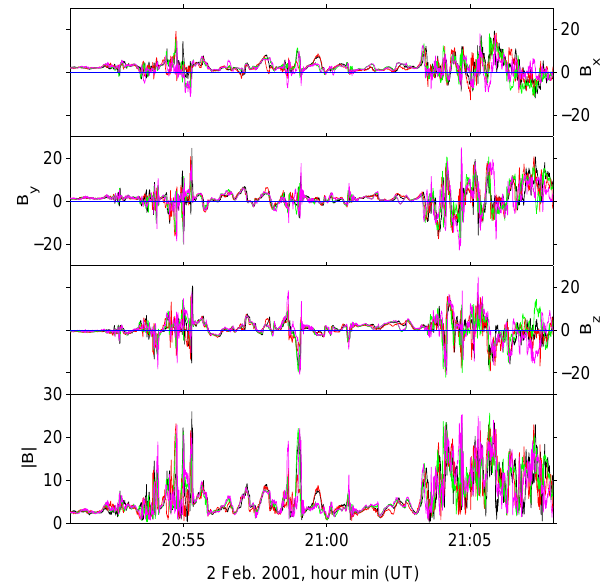
Fig. 4. Magnetic field data from the four spacecraft at 5 vectors/s from a region of the shock transition. The spacecraft are indicated by black (Cluster 1), red (2), green (3) and magenta (4). Panels show the three magnetic field components ( B x , B y , B z ) in GSE coordinates, and the magnetic field magnitude ( | B | ), all in